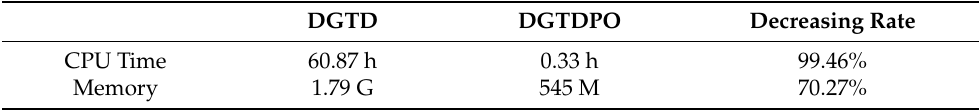
Table 2. The CPU time and memory of DGTD and DGTDPO for a PEC sphere-plate composite object. DGTD DGTDPO Decreasing